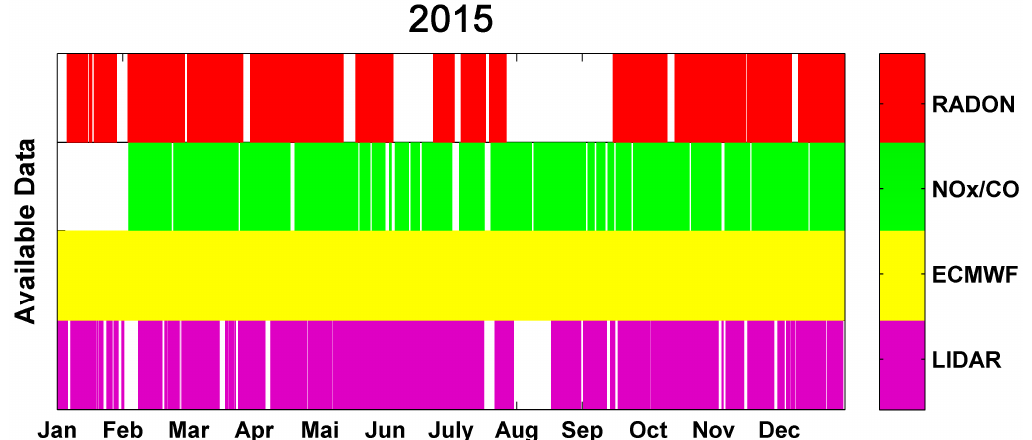
Figure 1. The available data from the main instruments used in the determination of the boundary layer height. Red: Radon-222, Green: NO x /CO, Yellow: ECMWF, and Violet: LIDAR.